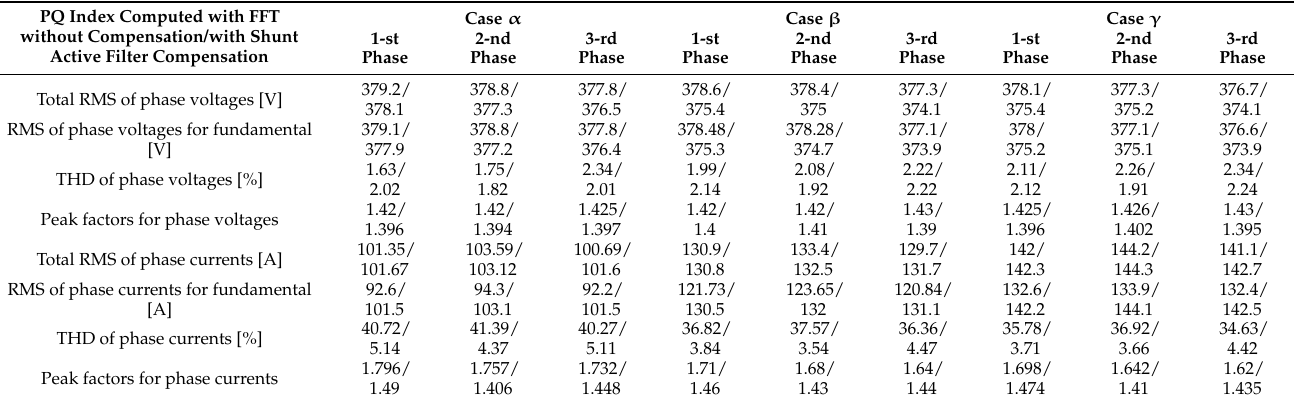
Table 5. Power quality indices for phases without compensation/with shunt active filter compensa- tion for α , β , and γ cases.